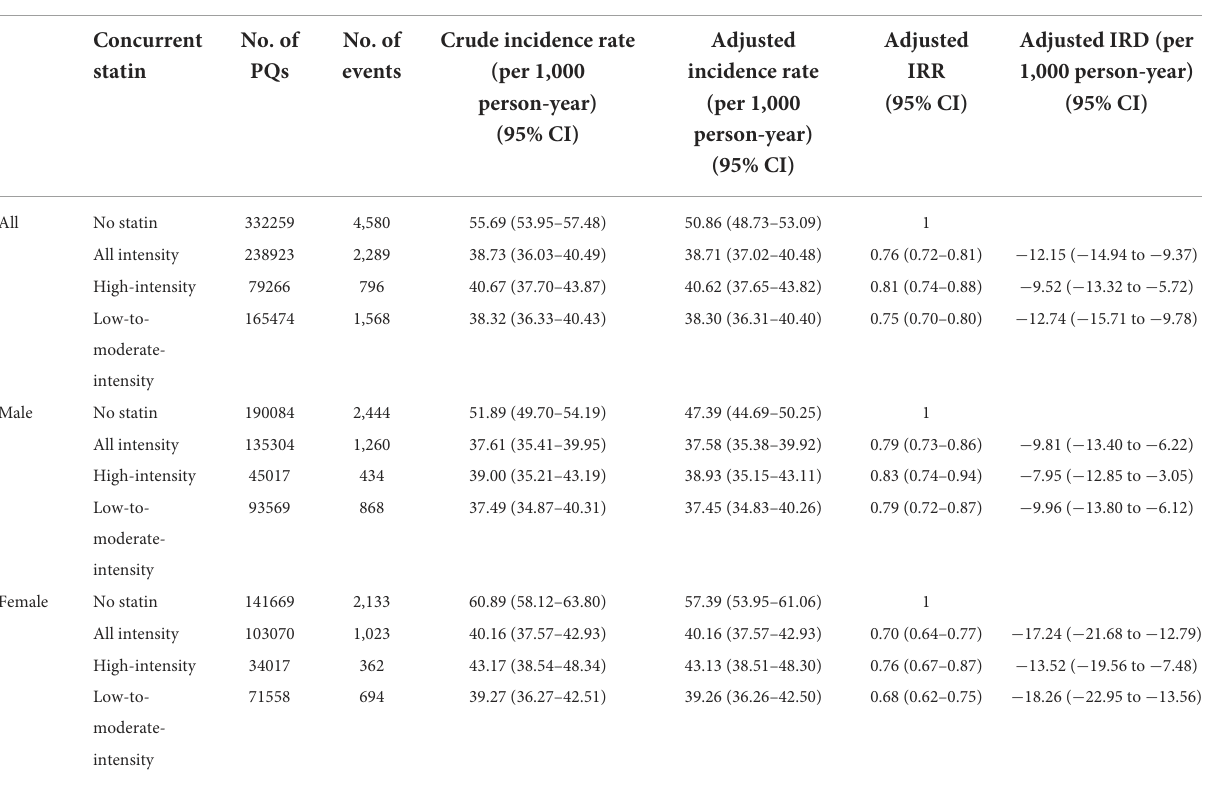
TABLE 2 Major bleeding among DOAC using